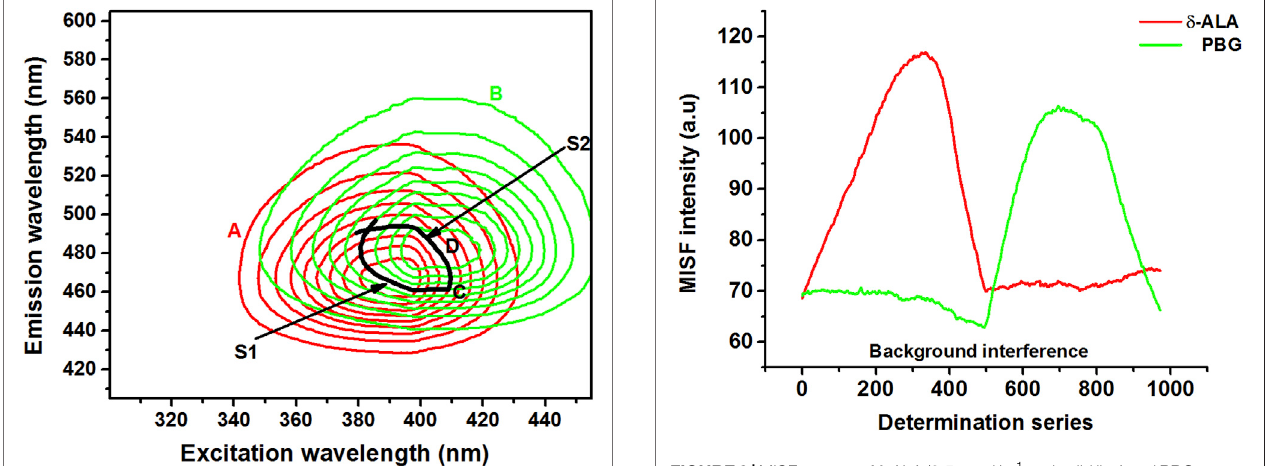
FIGURE3| MISFspectraof δ -ALA(2.5 μ molL − 1 ,redsolidline)andPBG (6.5 μ mol L − 1 , green solid line)